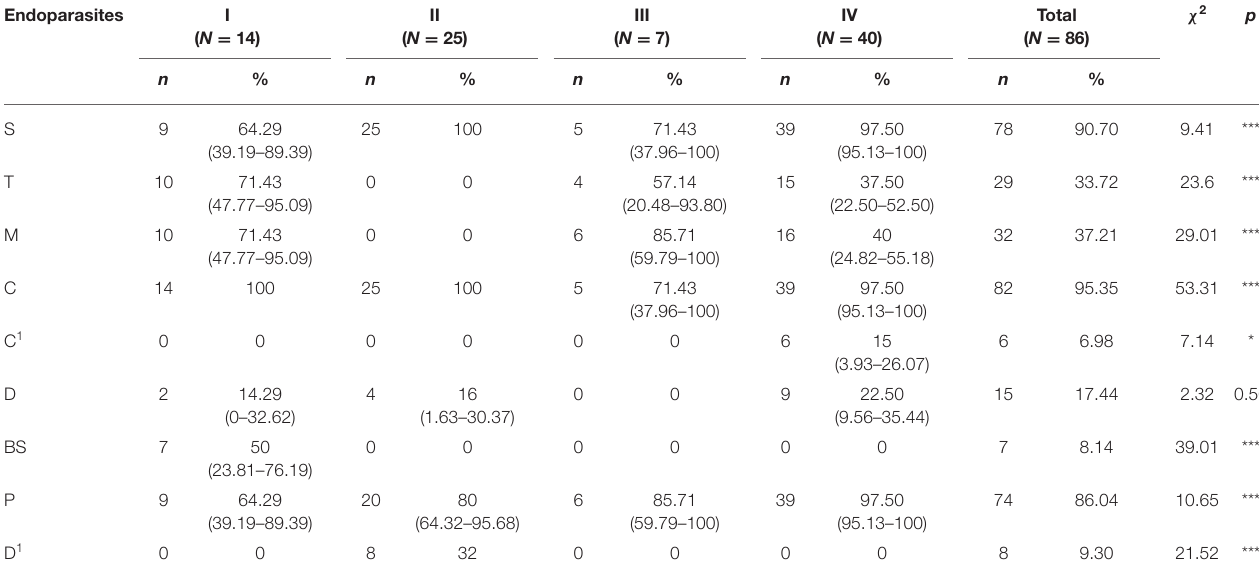
TABLE 4 | Prevalence of endoparasites in goats examined in four farms in Serbia.